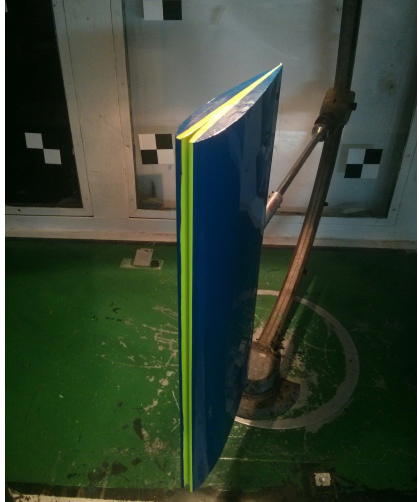
Figure 22. G2A30.7 wing segment fixed to the test apparatus during wind tunnel